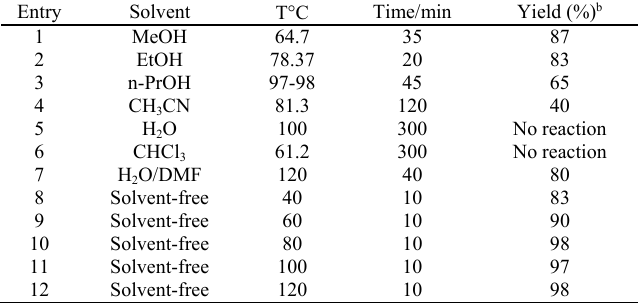
Table 2. Optimization of the reaction conditions a .